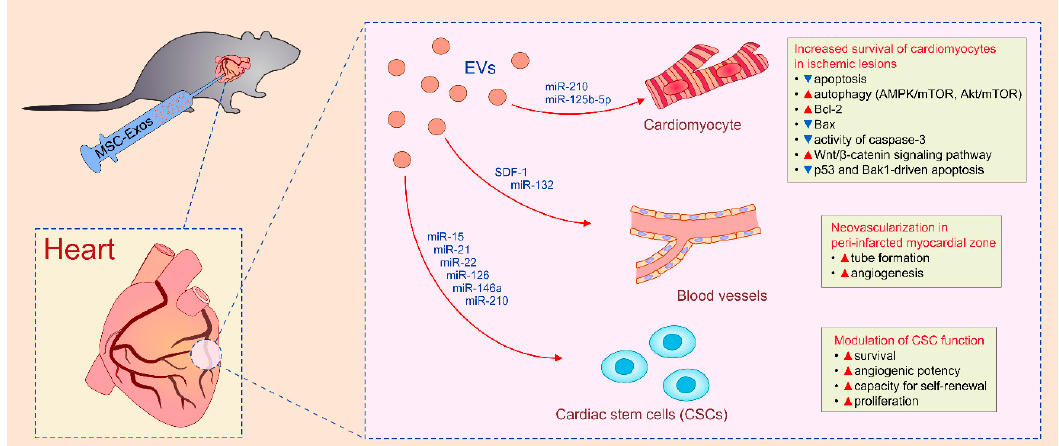
Figure 4. Therapeutic potential of MSC-sourced secretome in myocardial regeneration. MSC-derived secretome promote myocardial regeneration by preventing apoptosis of cardiomyocytes, by inducing neo-angiogenesis in ischemic regions and by promoting survival, angiogenic potency and capacity for self-renewal of cardiac stem cells (CSCs). MSC-derived extracellular vesicles (EVs) increased survival of cardiomyocytes in ischemic lesions by preventing apoptosis and by inducing autophagy via modulation of AMPK/mTOR, Akt/mTOR and Wnt/ β -catenin pathways. Administration of MSC-derived exosomes (Exos) resulted in up-regulation of anti-apoptotic Bcl-2, down-regulation of pro-apoptotic Bax and suppressed activity of caspase-3 in cardiomyocytes. MSC-Exos-mediated delivery of miR-210 and miR-125b-5p increased survival of cardiomyocytes by preventing p53 and Bak1-driven apoptosis. MSC-Exo-mediated delivery of stromal cell-derived factor-1 (SDF-1) and miR-132 resulted in enhanced tube formation and increased angiogenic capacity of endothelial cells (ECs). MSC-Exos-mediated modulation of CSCs function has been attributed to the delivery of miR-15, miR-21, miR-22, miR-126, miR-146a, miR-210 which prevented apoptosis and promoted survival of CSCs. Modulation of angiogenesis in peri-infarcted myocardial zone was, at least partially, responsible for MSC-Exo-induced beneficial effects [115]. In line with our recently published study that emphasized the important role of stromal cell-derived factor 1 (SDF-1) in neo-angiogenesis [116], Gong and colleagues showed that SDF-1-overexpression in MSCs-Exos inhibited apoptosis of